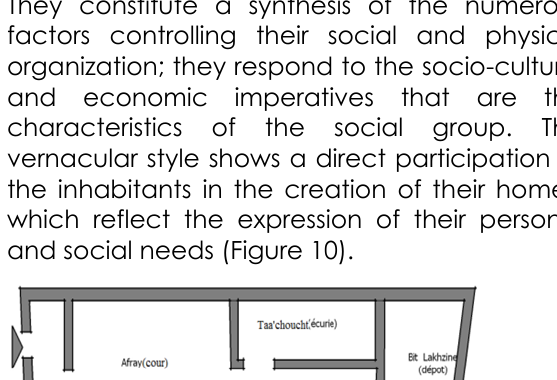
Figure 9. Example of external transformation by the use of new materials which are not local at Warka (Authors. 2015) They constitute a synthesis of the numerous